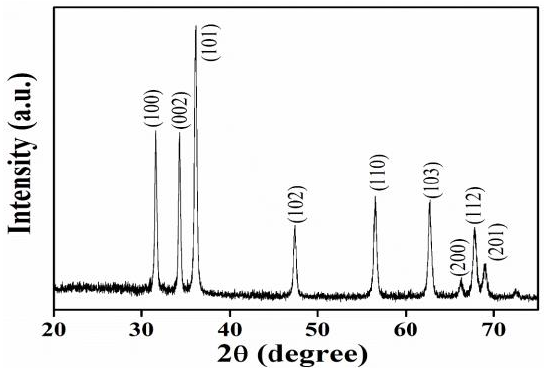
Figure 1. XRD spectrum of ZnO NPs.